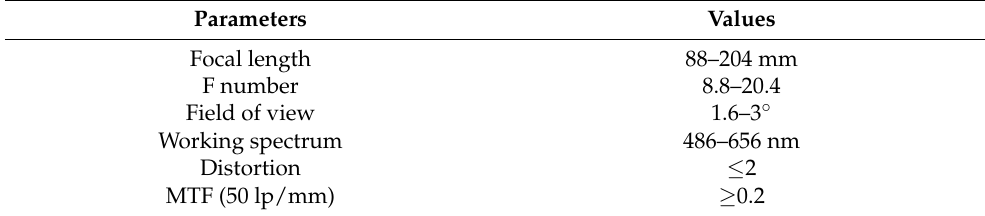
Table 1. Design index of the zoom system.